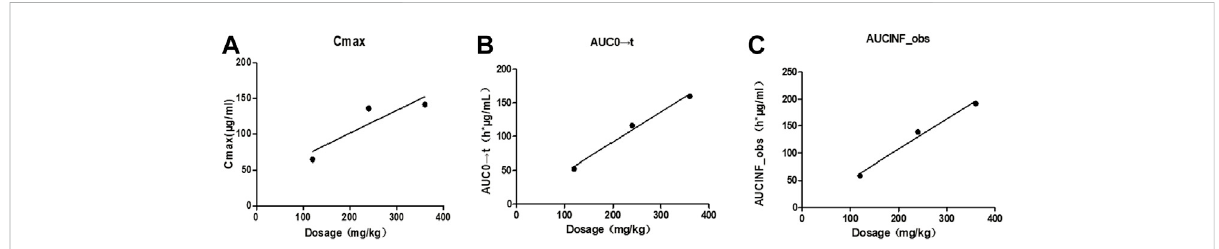
FIGURE 3 Correlation curves of mean pharmacokinetic parameters and dosage of Beagles. Note: (A) . The correlation curve of mean Cmax/dose of Beagles; (B) . The correlation curve of mean AUC0 → t/dose of Beagles; (C) . The correlation curve of mean AUC0 → ∝ /dose of Beagles.